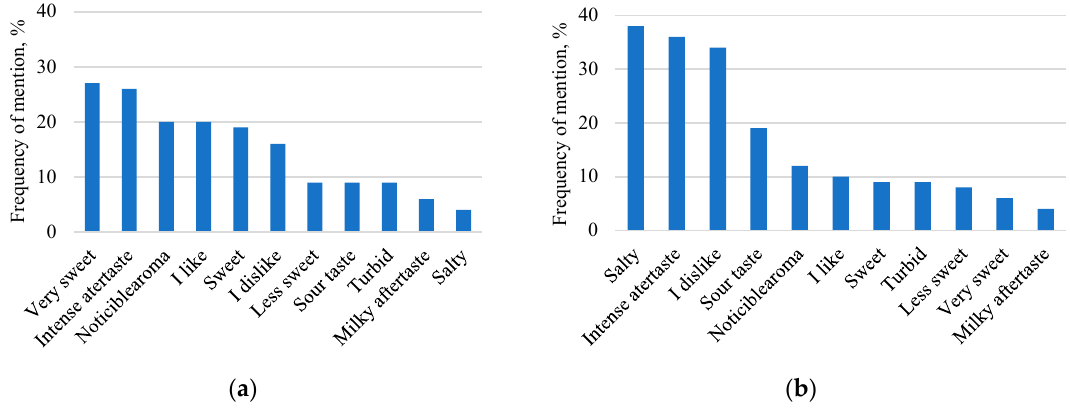
Figure 6. Frequency of the 11 most frequently mentioned descriptions that participants noted during evaluation. Glucose-galactose syrups of second-stage fermentation from sweet whey permeate ( a ); Glucose-galactose syrups of two-stage fermentation from acid whey permeate ( b ). Regardless of the whey origin, the terms “Very sweet” (27%) and “Intense aftertaste” (26%) were the most cited for syrups from sweet whey permeate, but the words “Intense aftertaste” (36%), “Salty” (38%) and “I dislike” (34%) were the most cited for syrups from